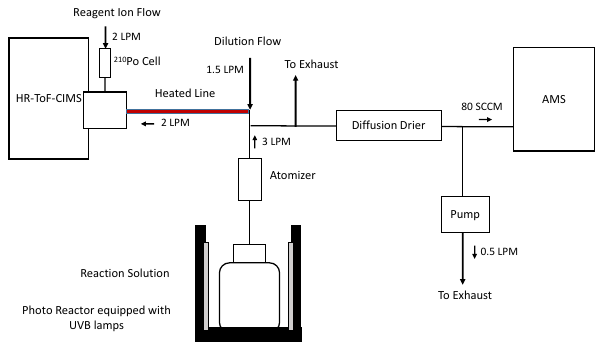
Figure 1. The experimental